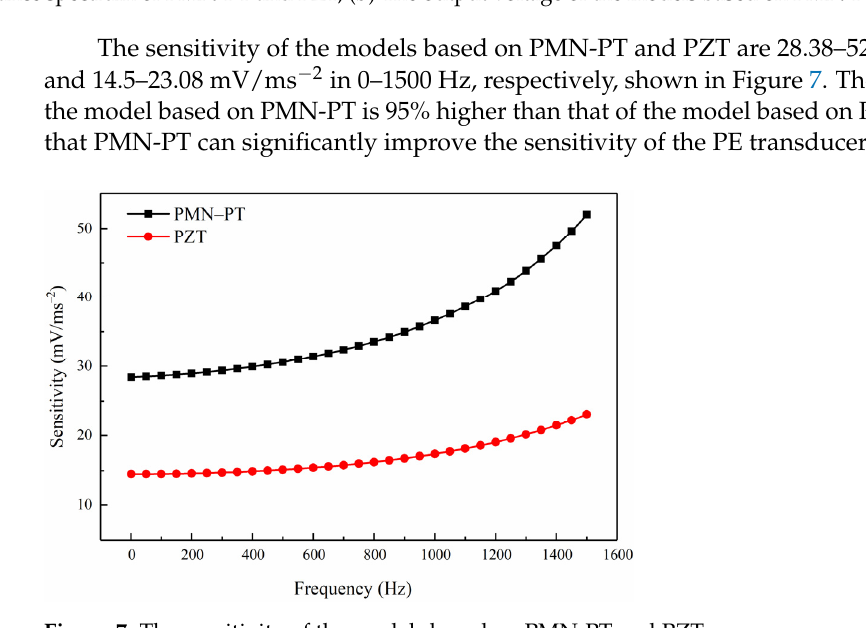
Figure 6. ( a ) The impedance spectrum of PMN-PT and PZT; ( b ) The output voltage of the models based on PMN-PT and PZT.